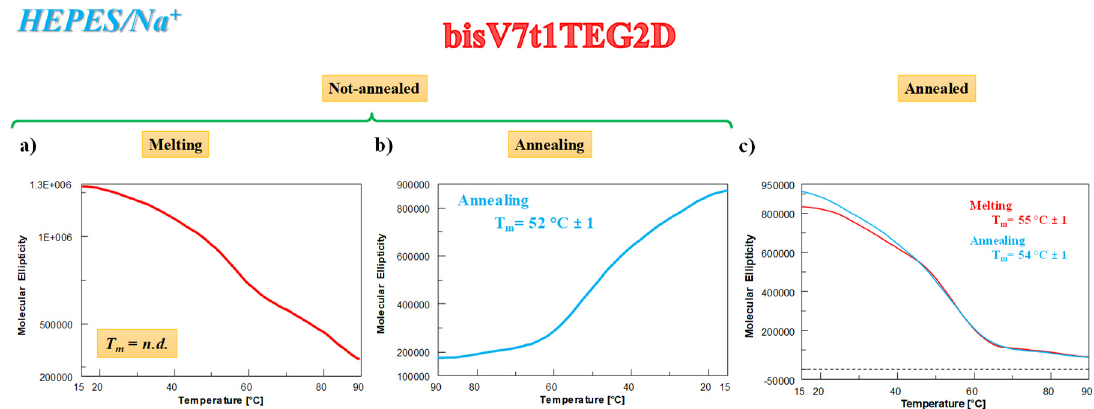
Figure 5. CD analysis on bisV7t1TEG2D at 2 μ M concentration in the selected HEPES/Na + buffer solution in both N.A. and A. form. ( a ) CD-melting and ( b ) CD-annealing profiles (red and light blue lines, respectively) of N.A. bisV7t1TEG2D recorded at 262 nm using a scan rate of 1 ◦ C / min; ( c ) overlapped CD-melting and CD-annealing profiles (red and light blue lines, respectively) of A. bisV7t1TEG2D , both recorded at 262 nm (scan rate: 1 ◦ C /